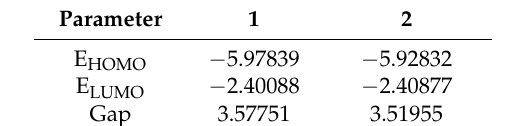
Table 7. The frontier orbital energy (eV) of the studied isomers.